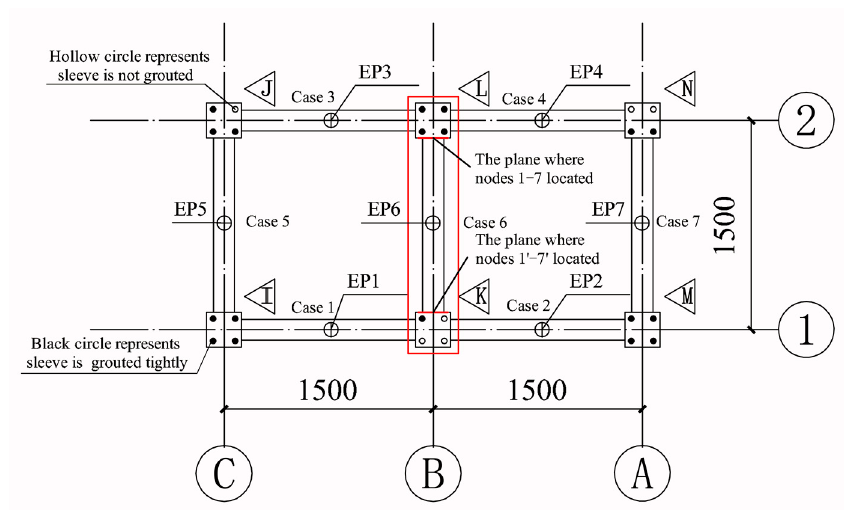
Figure 15. Defects and excitation point (EP) layout of the second floor. Sensors 2020 , 20 , x FOR PEER REVIEW